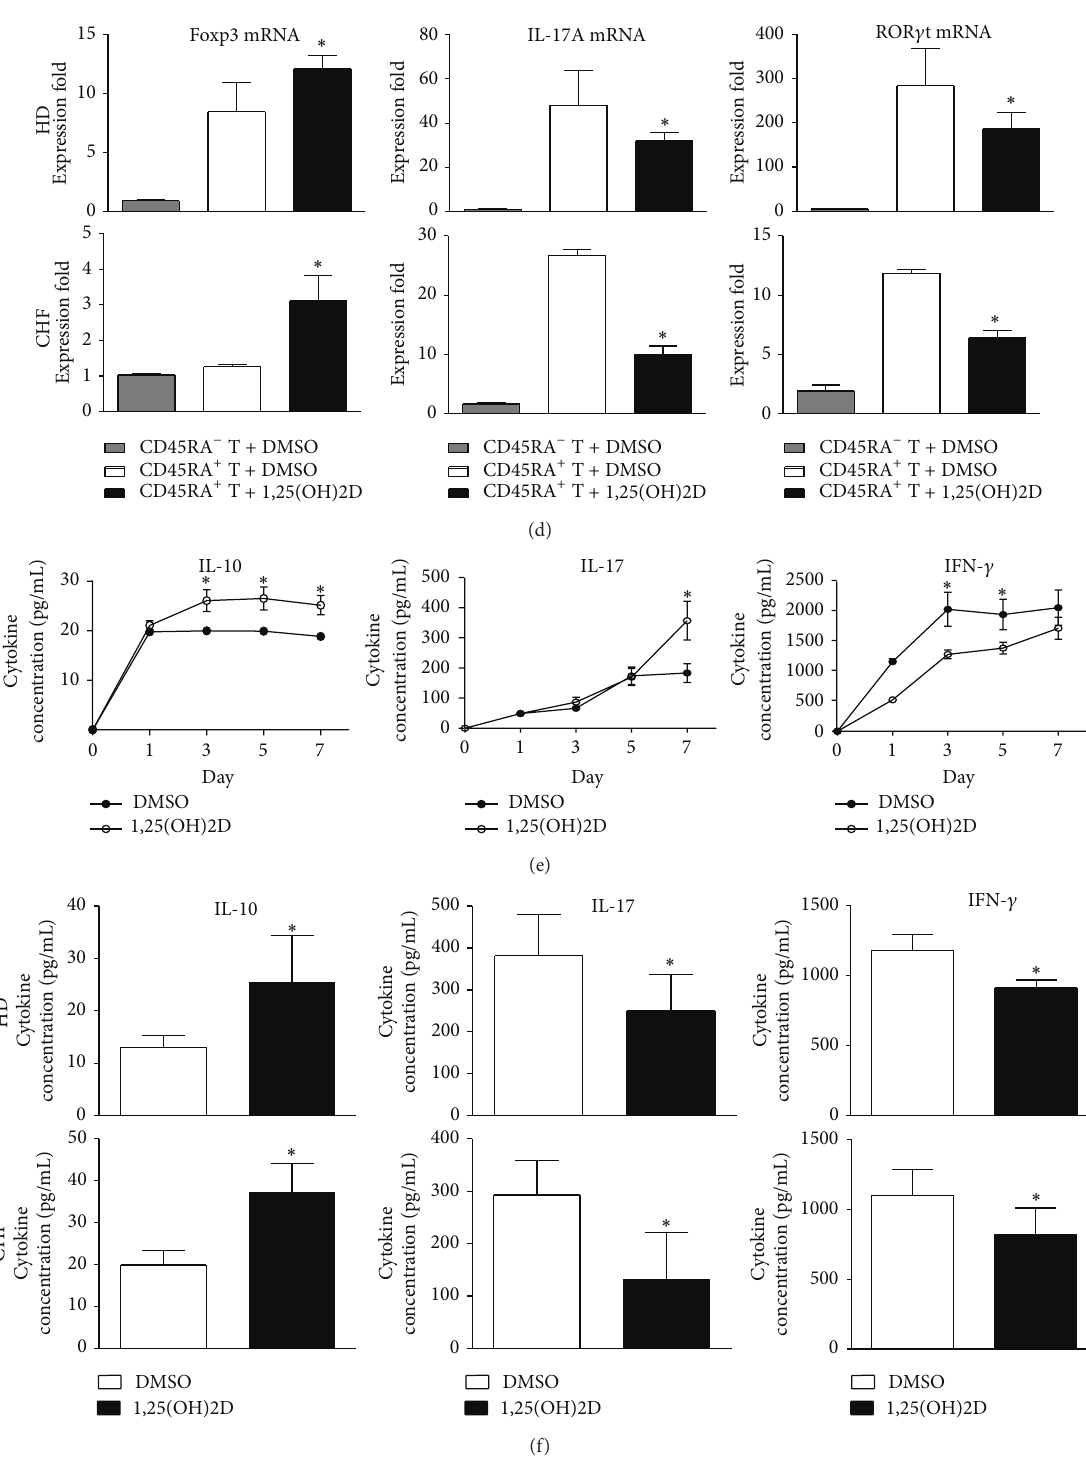
Figure 5: 1,25(OH)2D elevated Foxp3 expression while it inhibits IL-17A in CD4 + CD45RA + T cells. (a) Representative flow cytometric dot plots and diagrams of IFN- 𝛾 and IL-17 or Foxp3 and IL-17 double staining in CD4 + T cell after 5 days of culture with 1,25(OH)2D or DMSO. (b) CD4 + CD45RA + T and CD4 + CD45RA − T cells were purified from HD. IL-17, IFN- 𝛾 , or Foxp3 expressions were detected by FACS after 7 days of culture. (c) CD4 + CD45RA + T cells were purified from HD and CHF. IL-17, IFN- 𝛾 , or Foxp3 expressions were detected by FACS after 7 days of culture. (d) Foxp3, IL-17, and ROR 𝛾 t mRNA expressions in CD4 + CD45RA + T cells after 7 days of culture, CD45RA + CD4 − T cells as negative control. (e) HD CD4 + CD45RA + T cells culture supernatant was collected on days 0, 1, 3, 5, and 7 and detected IL-10, IL-17, and IFN- 𝛾 by ELISA. (f) CD4 + CD45RA + T cells were purified from HD and CHF. IL-10, IL-17, and IFN- 𝛾 were detected by ELISA on day 7. Data are representative of five independent experiments. Results shown are the mean ± SEM; * 𝑃 < 0.05